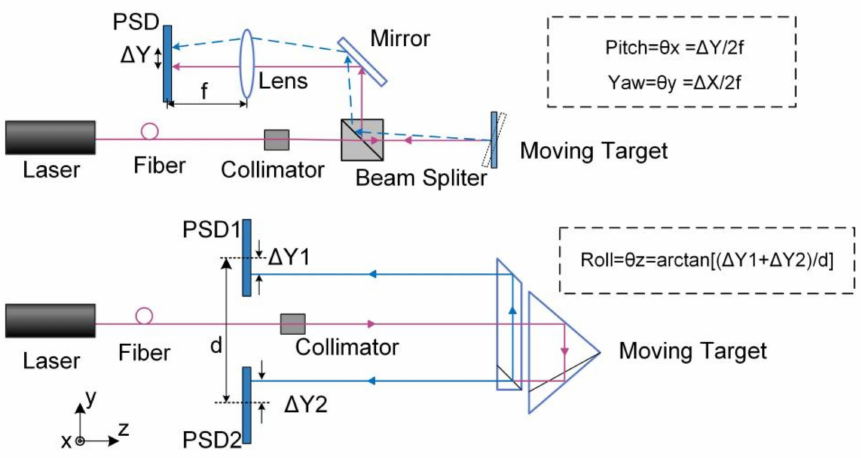
Figure 9. Strategies of measuring pitch, yaw, roll, ∆ X and ∆ Y based on laser collimation method. Based on laser collimation method, Feng et al. developed a novel system for measuring 6-DOF motion errors of linear stage using a mono-frequency laser interferometer [60]. The schematic of the system is shown in Figure 10, which adopts a rhombic prism (BSP) and a cube retroreflector (RR) as the measured target. The distance is measured by the detector D based on laser interference method. Roll angle, ∆ X and ∆ Y are detected by the combination of QD1 and QD2. Pitch and yaw are detected by PSD1 based on laser collimation method. Laser beam drift is measured by PSD2 based on the principle of common-path compensation. The experiments verified that the resolution is 0.2 µ m and 0.25” for translation and rotation, respectively. The accuracy is 0.8 µ m for ∆ X and ∆ Y in the measurement range of ± 100 µ m. The accuracy of pitch, yaw and roll are 1.3”, 1.0” and 2.0” in the measurement range of ± 100”, respectively.